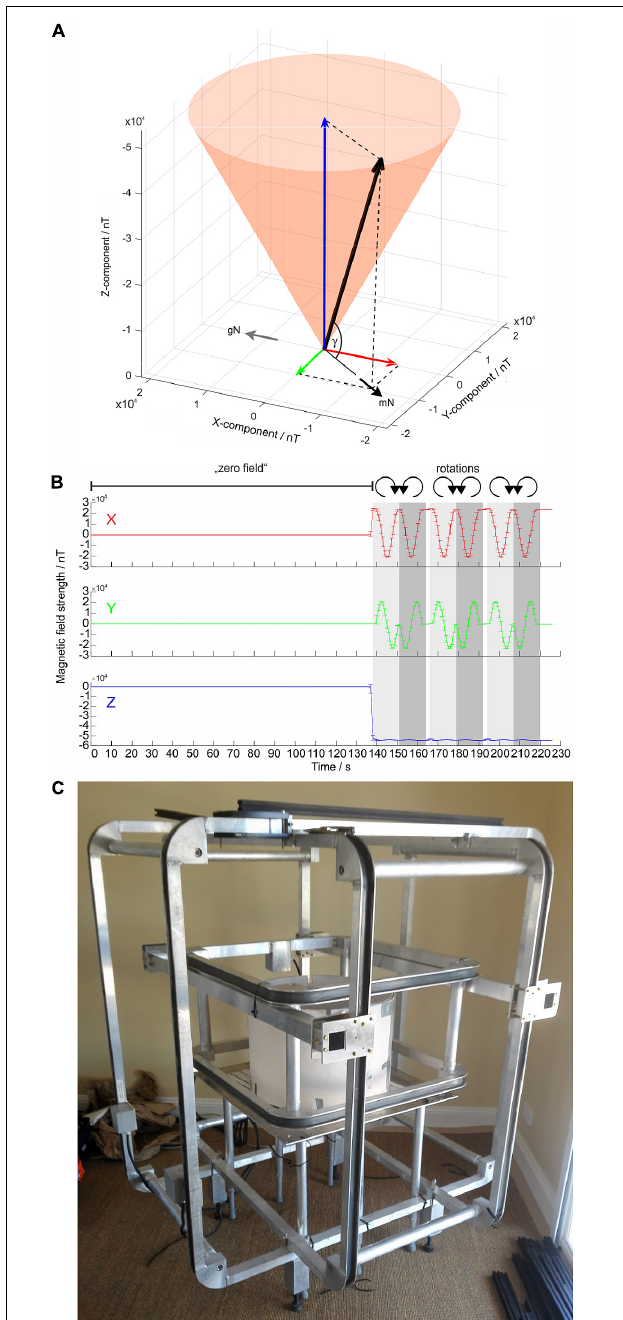
FIGURE 5 | Magnetic stimuli generated by the Helmholtz coil system. (A) The experimental magnetic field vector ( thick black arrow ) can be subdivided into 3 vectors (or component vectors) which are oriented perpendicular to each other: the X- ( red arrow ), Y- ( green arrow ), and Z-component ( blue arrow ). The orange cone indicates the rotational movement pattern of the resulting magnetic field vector, which points toward magnetic North (mN). (B) The magnitude of the X-component ( red arrow ), Y-component ( green arrow ), and Z-component ( blue arrow ) of the experimental magnetic field vector, measured at the center of our Helmholtz coil system, plotted as a function of time for a specific magnetic stimulus sequence (shown here as an